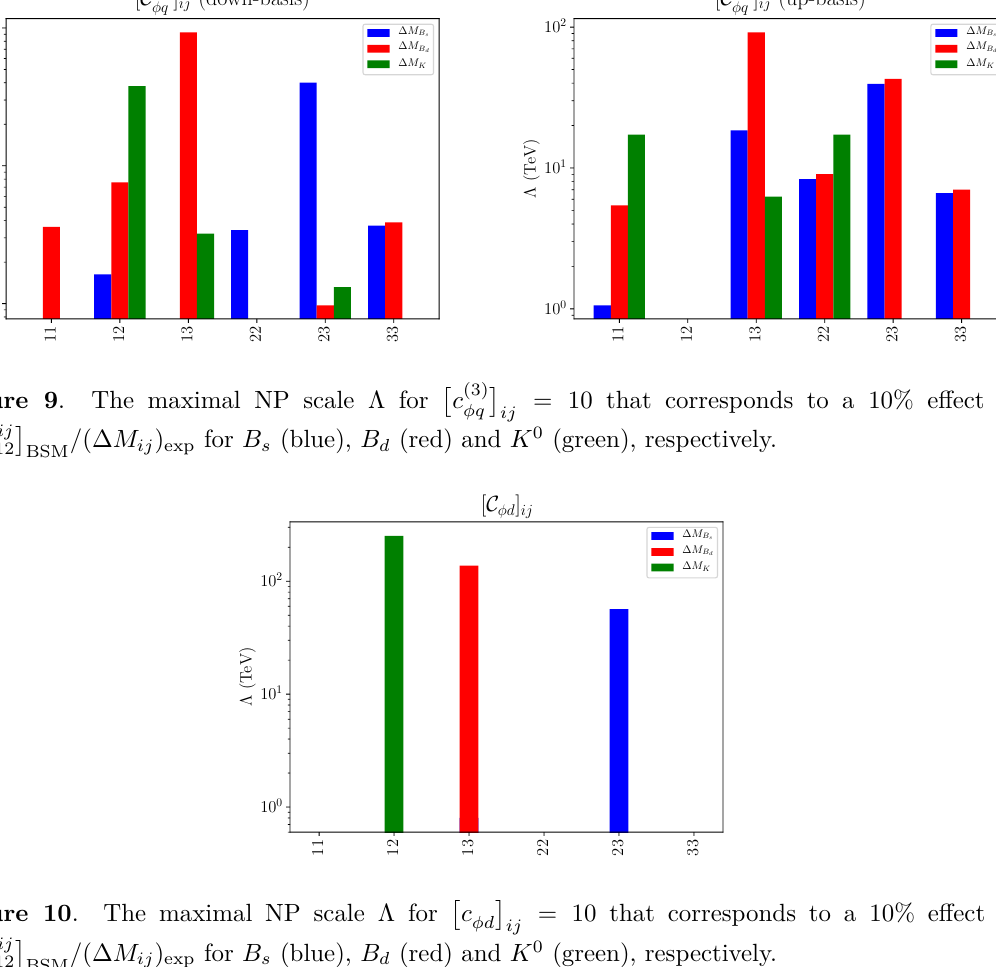
(cid:2) (cid:3) c = 10 that corresponds to a 10% effect in φd ij